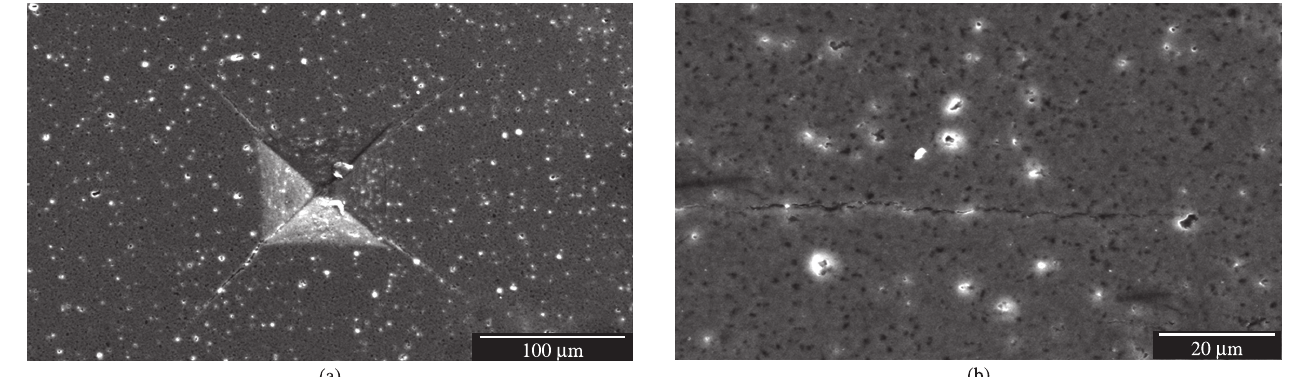
Figure 3. Typical scanning electron micrographs of: (a) Vickers indent; (b) propagating crack in silicon nitride based